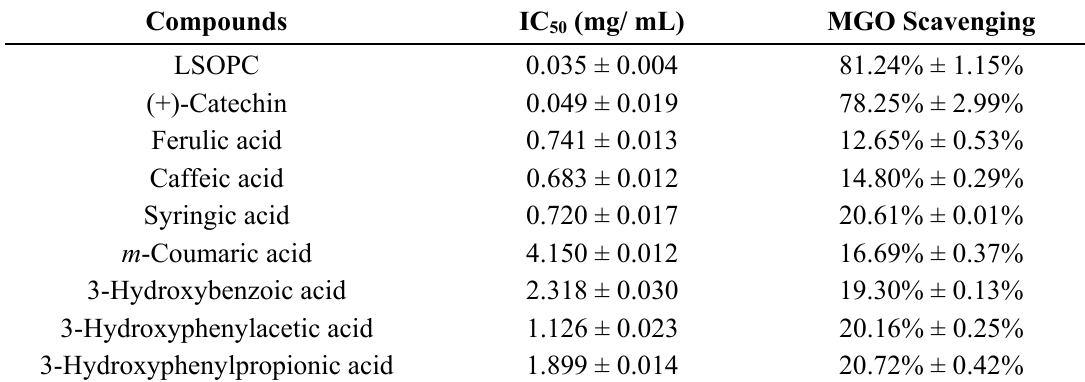
Table 2. Anti-glycation activity and MGO scavenging activity of LSOPC and its